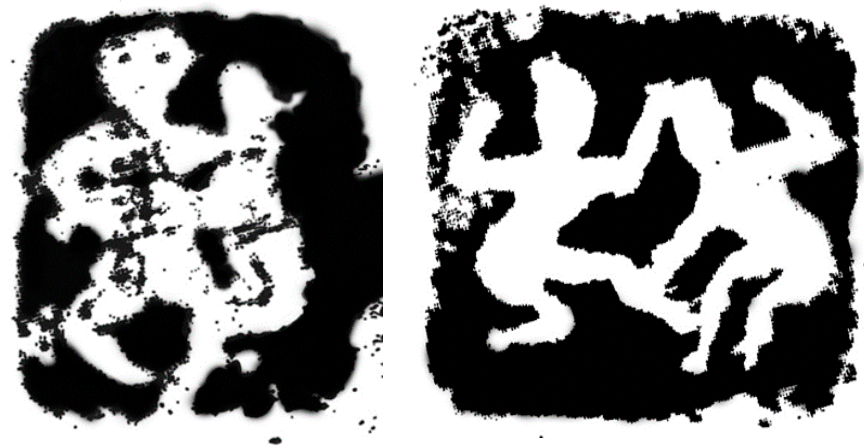
Figure 20. The Xiaoxingyin depicting the scene of Jiaodi. The Han Dynasty. Inventory: 78 and 79. Sketched by author. Picture source: National Palace Museum (1984), pp. 79–80.